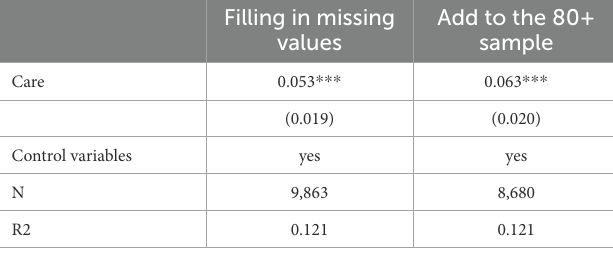
TABLE 6 Regression results of filled samples.